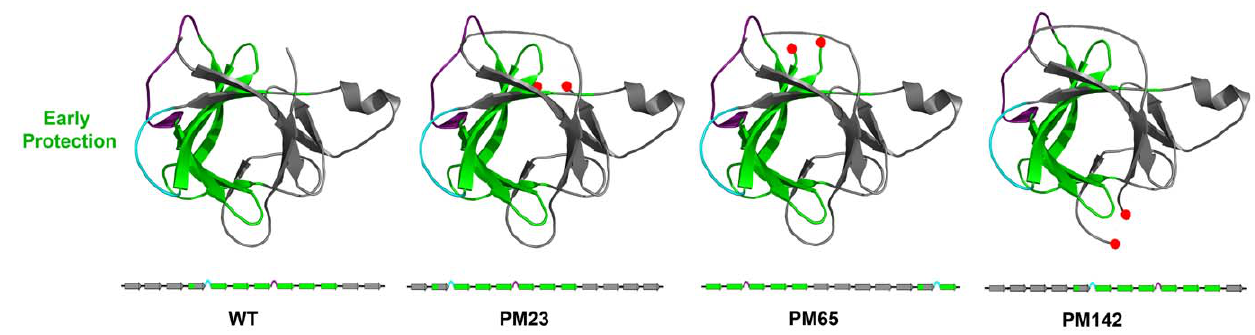
Figure 6. Summary plot of the results from the HDX pulse labeling experiments showing similar intermediate structure for WT and permutant proteins PM23, PM65, and PM142. Molecular and linear representations of IL-1 b and permutants indicating b -strands involved in early folding events for all protein variants. The strands of the proteins protected early in the refolding (28 msec) reaction are colored in green for clarity. Purple and cyan highlight the functional loops, the 90 9 s loop and b -bulge, respectively. Red spheres represent the new termini. For all proteins, the b -strands within the functional route shows similar early protection in refolding. PM76 is not shown, as the protein variant was not amenable to these experimental conditions (see material and methods).